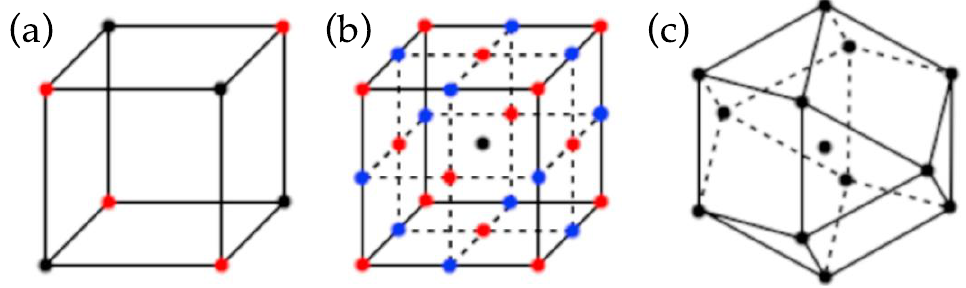
Figure 4. Schematic illustrations of examples of experimental design concepts/methods used in the statistical evaluation of MIPs. Examples of controllable variables include, amounts of functional monomer, cross-linking monomer and porogen. ( a ) Black points represent experimental runs in a three-factor fractional factorial design, while the combined red and black points represent a three- factor full factorial design. ( b ) Red and central black points depict a three-factor central composite design, while blue and central black points represent a Box-Behnken design. ( c ) A three-factor Doehlert design.